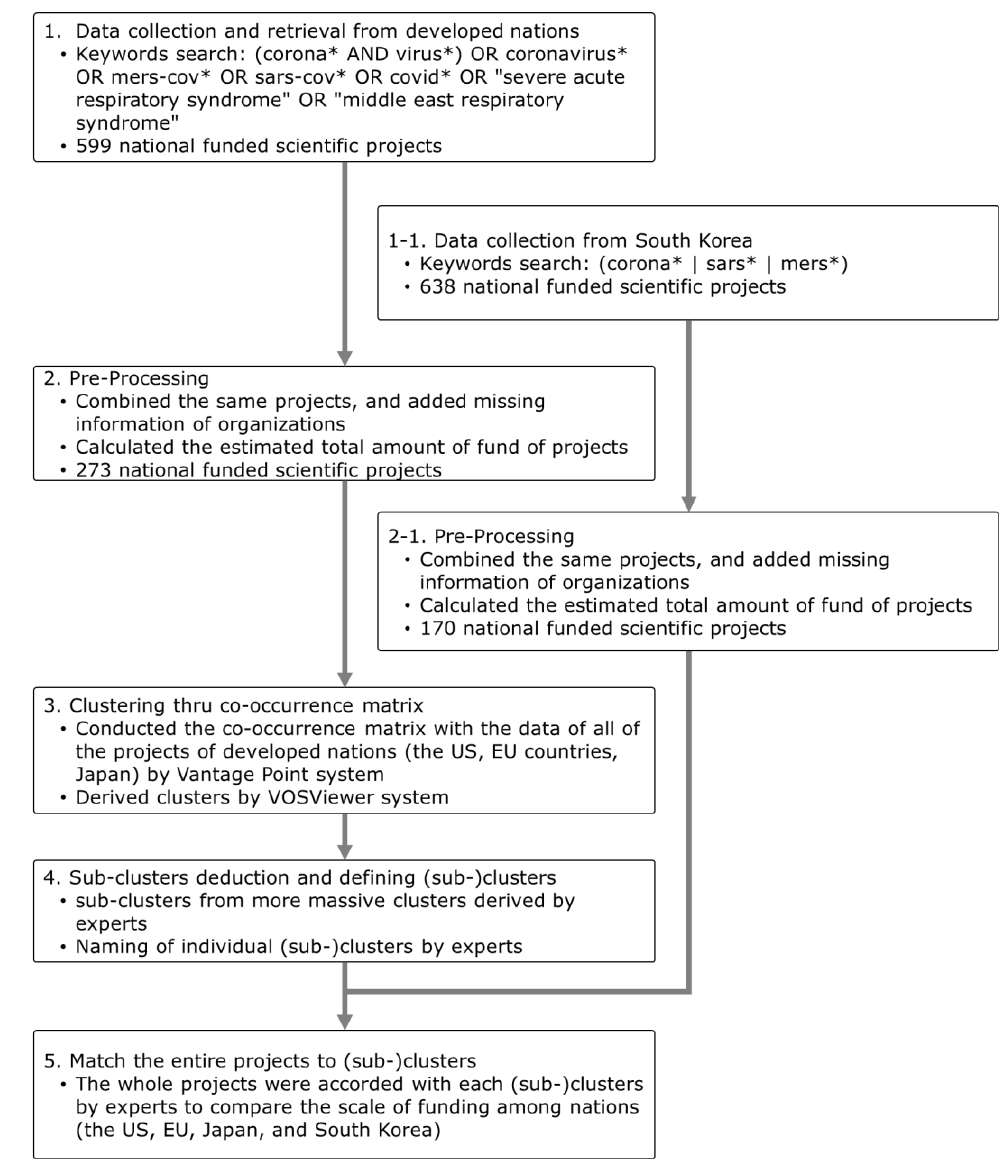
Figure 1. The workflow of the comparison of coronavirus-related R&D areas among the US, the EU, Japan, and South Korea. Search terms marked with an asterisk (*) are root or stem words, indicating that all possible suffixes are covered under the query.